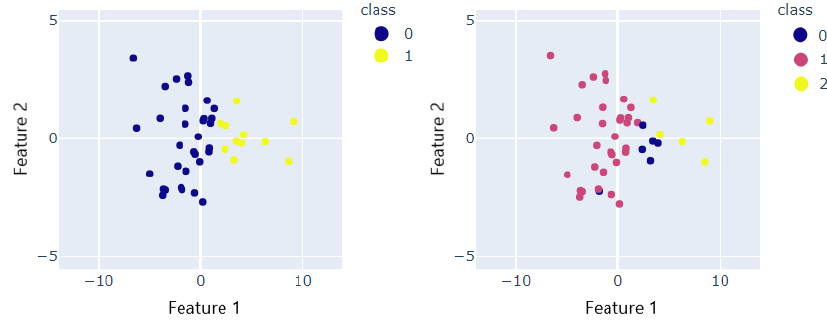
Figure 11. The cluster result when the number of clusters is 2 and 3, respectively.